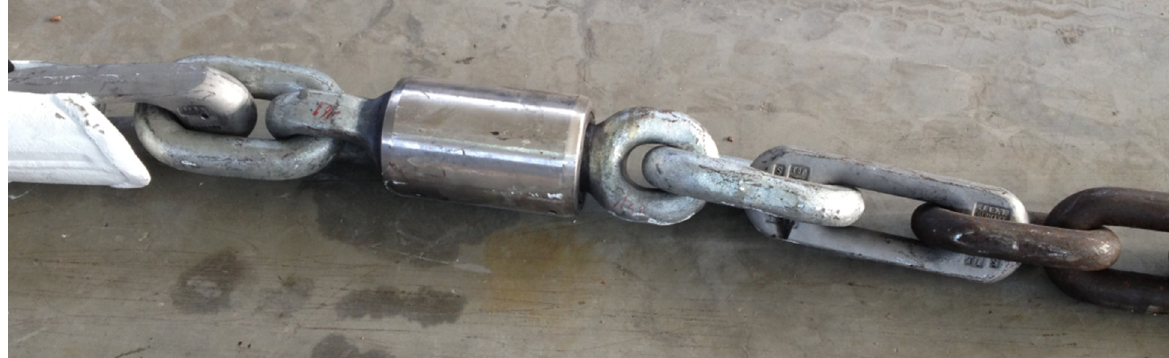
Figure 4. Chain swivel.